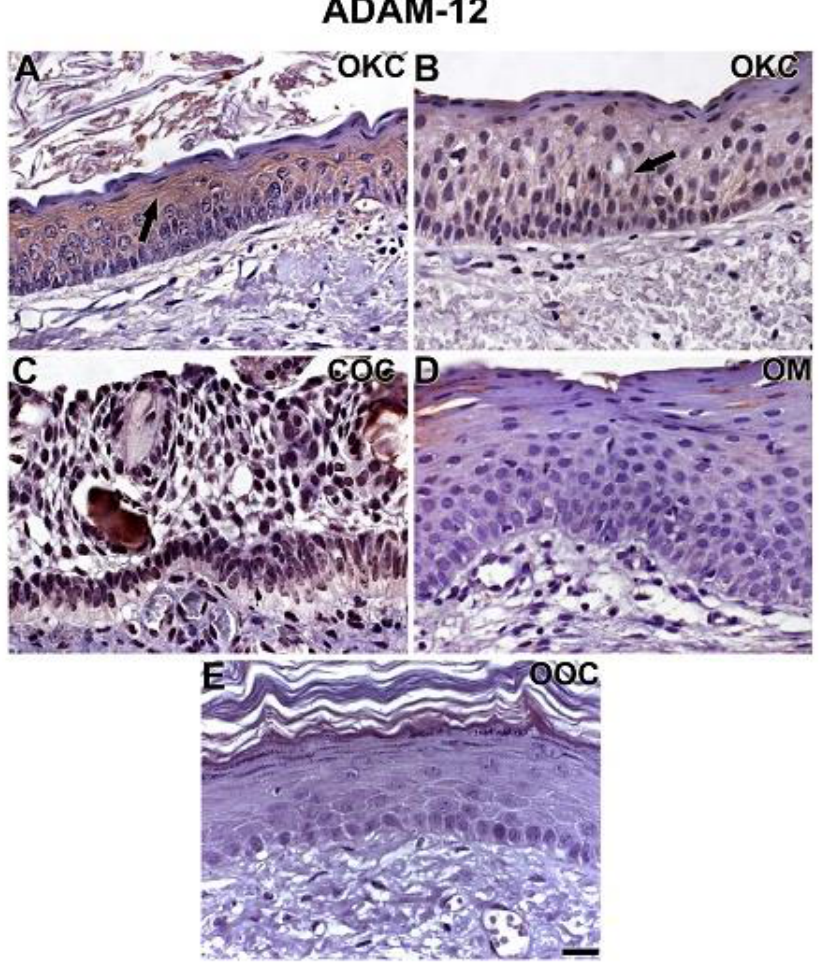
Figure 3. Immunolabelling of ADAM-12 in OKC ( A , B ), COC ( C ), OM ( D ), and OOD ( E ). ADAM-12 was expressed as dots in the cytoplasm of all epithelial strata ( A , B , arrows) in OKC. There was an even distribution in all the epithelial layers. ADAM-12 expression in COC was weak, as seen in the cytoplasm of basal cells, and less evident cytoplasmic expression was found in parabasal cells. Staining of ghost cells was not observed. ( C ) ADAM-12 expression in OM samples ( D ) and in OOC ( E ) showed a similar pattern seen in COC, the overall expression appeared to be very weak in both. Scale bar: 20 µm.